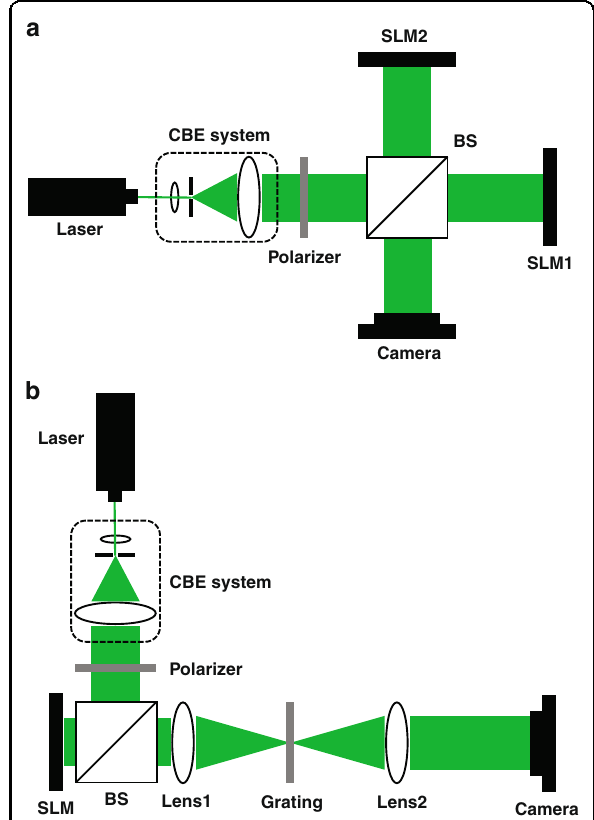
Fig. 6 Optical system of device method based on CAM. a Interference method; b grating method, where CBE system is collimating and beam expanding